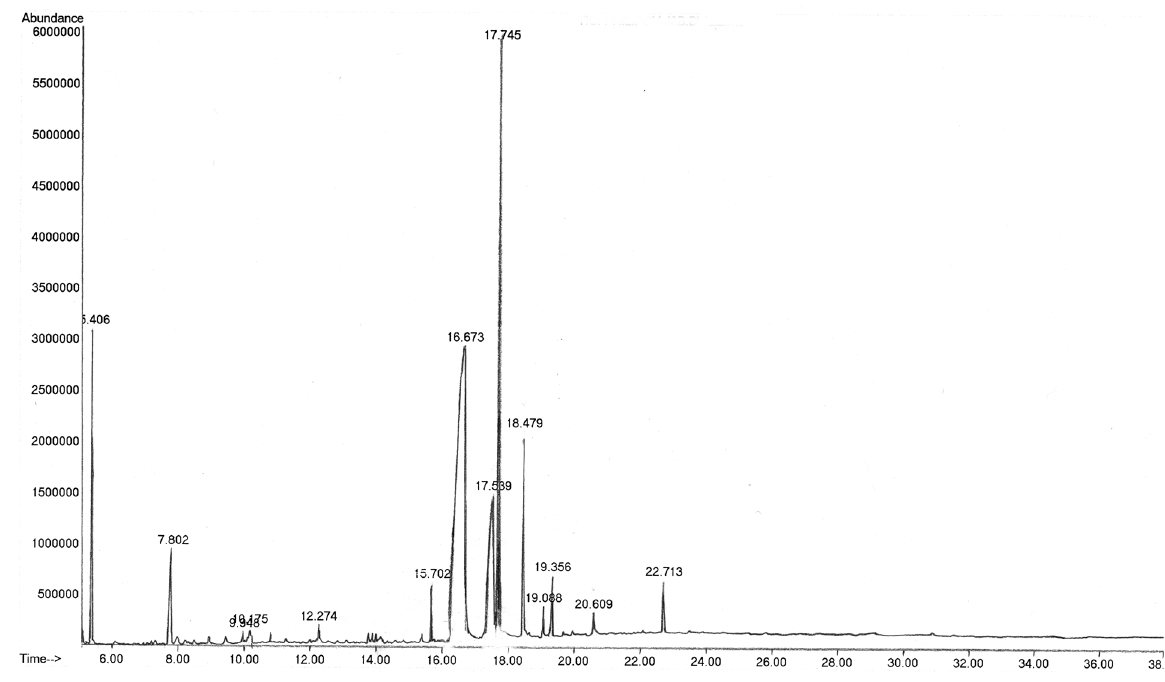
Fig. 1. GC-MS data of aerial parts of